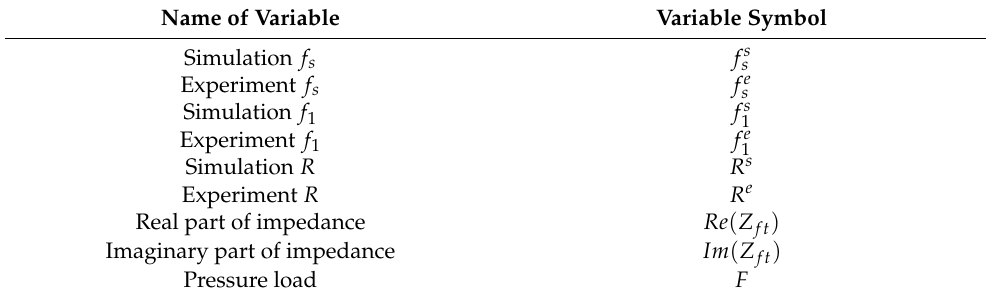
Table 1. Simplification of